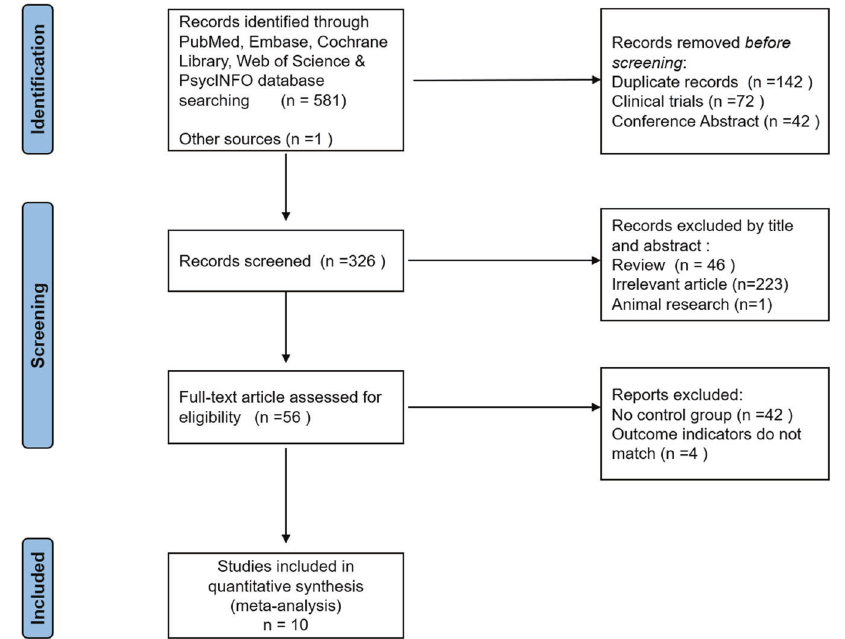
Fig. 1 Flow chart of study